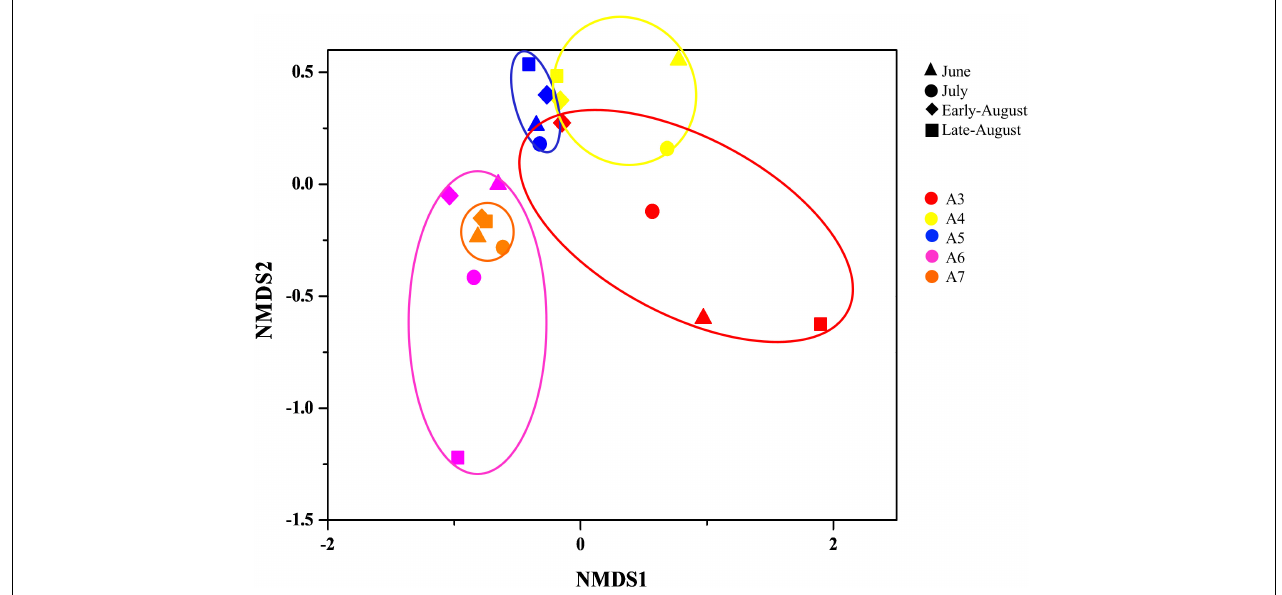
FIGURE 3 | Non-metric multidimensional scaling (NMDS) plot depicting phylum-level bacteria composition of each sample from different sampling time and site. (Axis define 2D space that allows the best spatial representation of sample distance, based on binary-jaccard distance with stress = 0.154. The points in different color represent sampling sites, different symbol represent sampling time, and the distance between points represents the degree of difference).